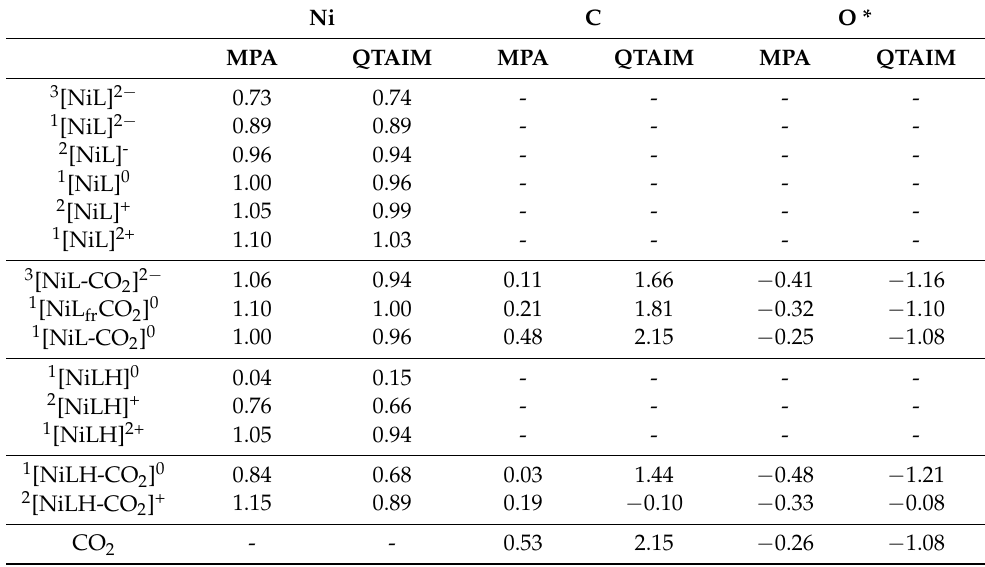
Table 2. B3LYP/6-311G* MPA and QTAIM charges of chosen atoms of the studied complexes. Ni